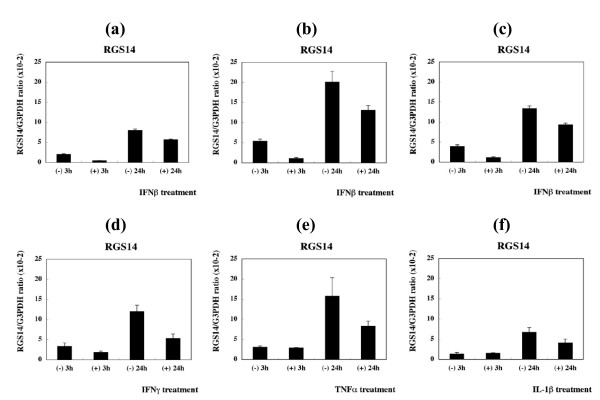
Real-time RT-PCR analysis of RGS14 expression in PBMC. See the footnote of Figure 1. The panels represent the expression of RGS14 in (a) #1, IFNβ; (b) #2, IFNβ; (c) #3, IFNβ; (d) #1, IFNγ; (e) #1, TNFα; and (f) #1, IL-1β.